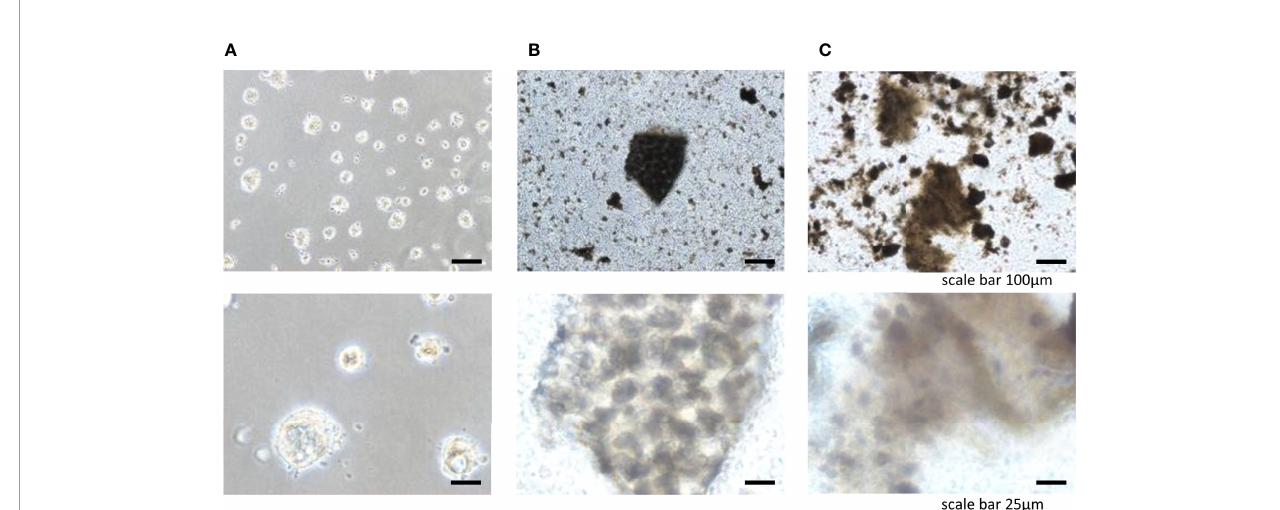
FIGURE 2 | Three-dimensional cell colonies BT20 in (A) Matrigel, (B) lung, (C)